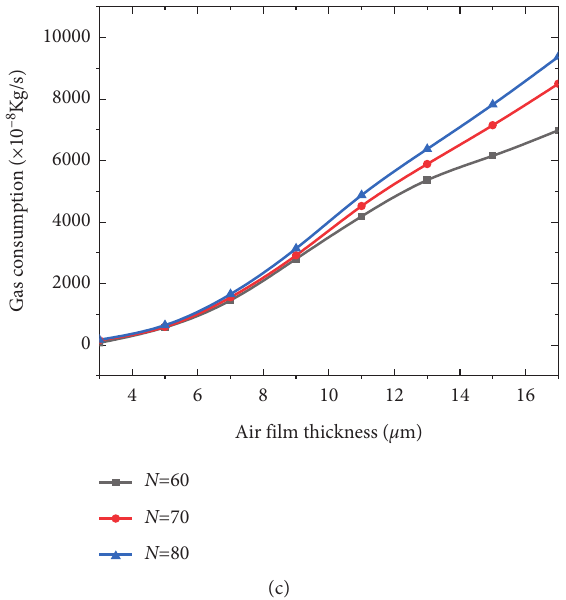
Figure 9: Effect of orifice number on static performance of